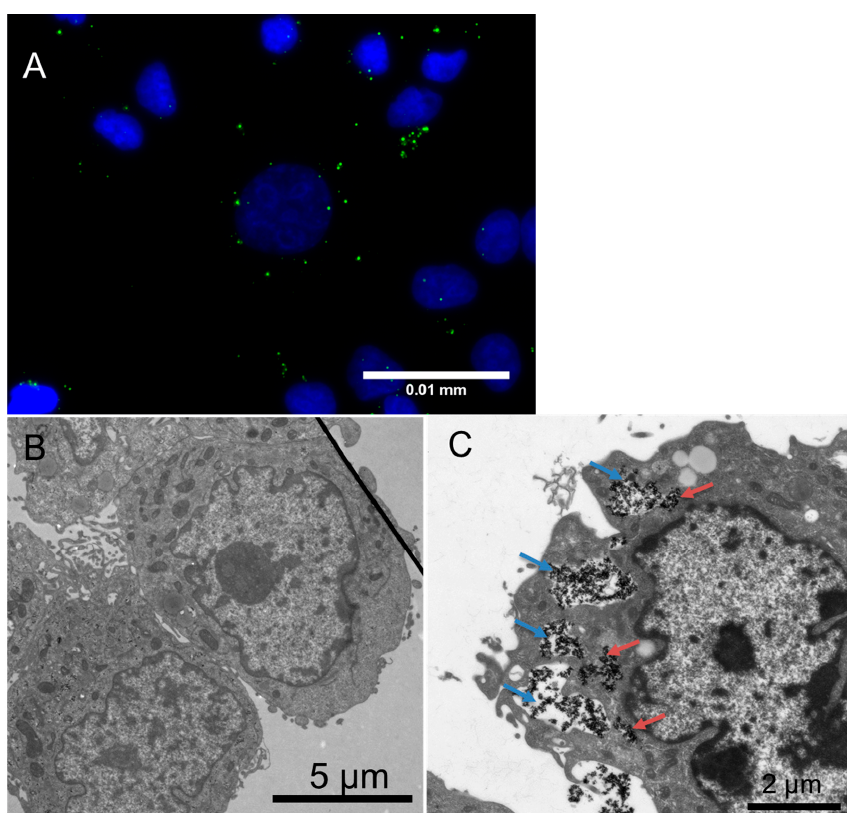
Figure 5. Fluorescence microscope image ( A ) of MCF-7 cells loaded with [Al 2 O 3 -PAC 16 ]@guest G3 @shell 1 (cell nucleus (blue) nanocarrier (green); TEM images of MCF-7 cells without NPs ( B ) with [TiO 2 -PAC 16 ]@guest G1 @shell 1 ( C ) in vesicles (blue arrows) and inside the cytoplasm (red arrows)